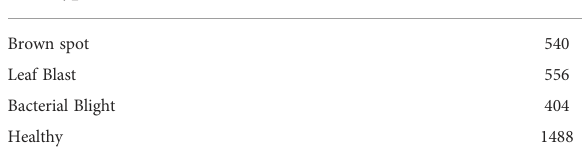
TABLE 2 Distribution of rice leaf